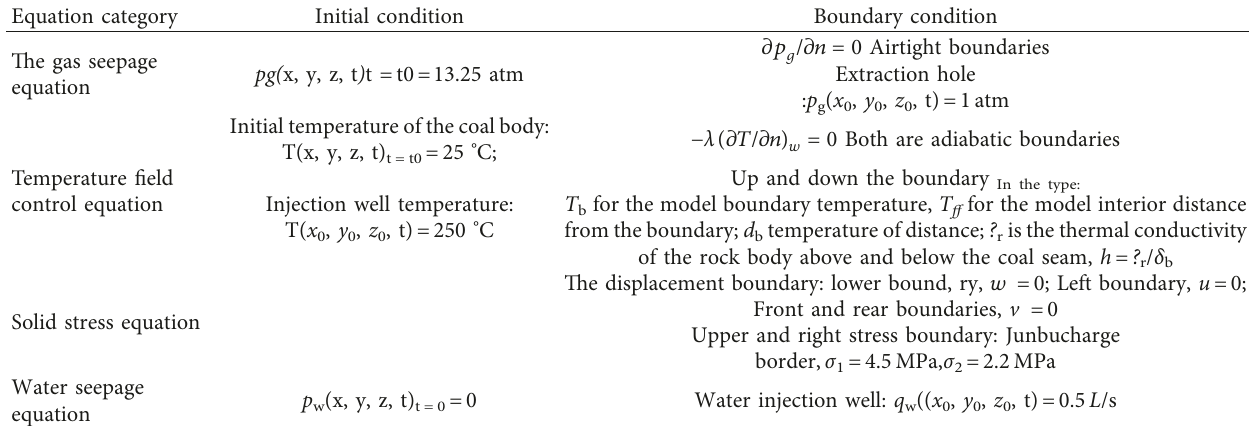
Figure 4: Mechanical model of the XZ plane. Table 2: Initial and boundary conditions.